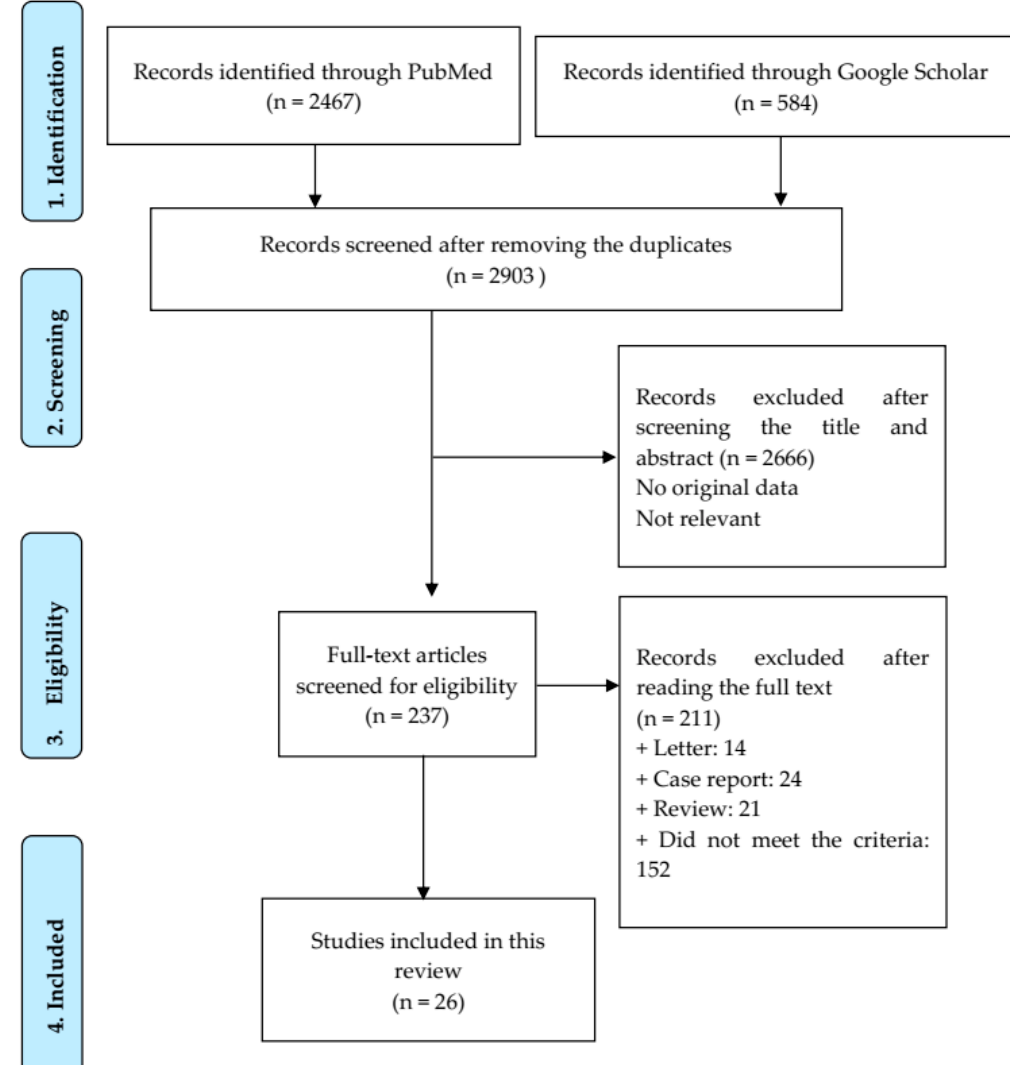
Figure 1. PRISMA flowchart of selected studies.